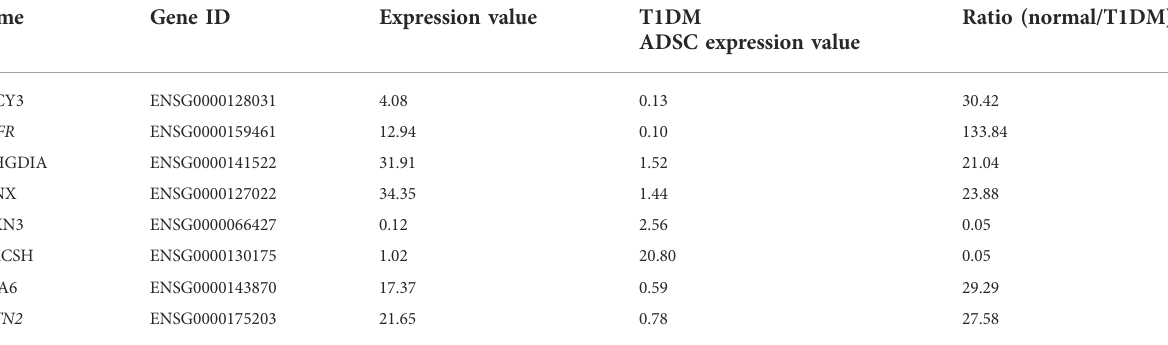
TABLE 2 Genes with variable expression in the vasopressin-regulated water reabsorption pathway and in protein processing in the endoplasmic reticulum